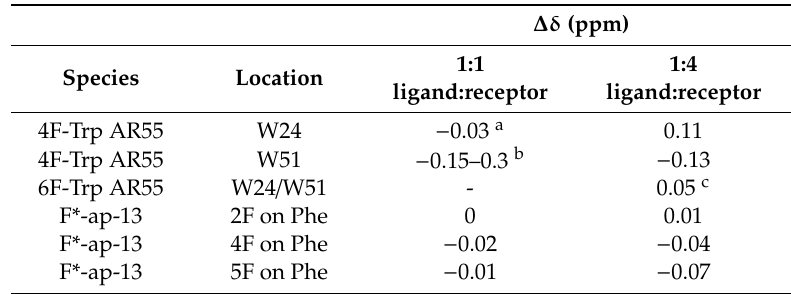
Table 1. 19 F chemical shift perturbation ( Δδ ) relative to control sample in absence of binding partner for AR55:F*-ap-13 interactions.